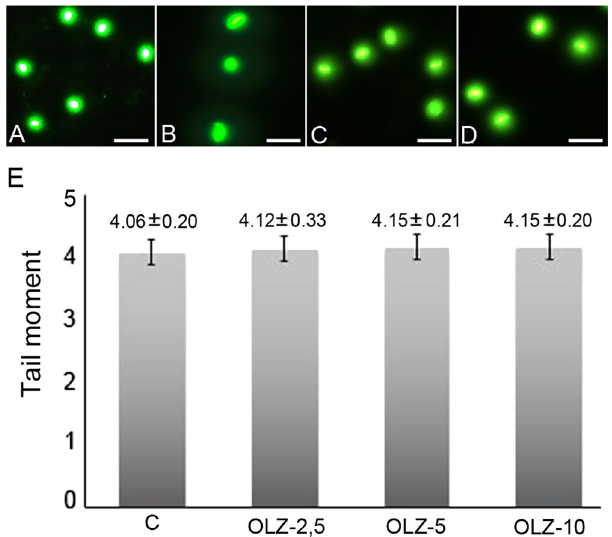
Figure 2. ( A–D ) Effect of olanzapine on the sperm DNA damage. ( A ) Sperm comet assay photo of control group ( B ) Sperm comet assay photo of OLZ-2.5 ( C ) Sperm comet assay photo of OLZ-5 ( D ) Sperm comet assay photo of OLZ-10. Stained with SYBR Green. Scale Bar:20 µm. ( E ) Sperm comet assay graphical illustration. No significant difference between groups in tail moment graph. Definition of abbreviations: OLZ-2.5 2.5 mg kg −1 olanzapine-administered rats for 28 days group, OLZ-5 5 mg kg −1 olanzapine-administered rats for 28 days group, OLZ-10 10 mg kg −1 olanzapine-administered rats for 28 days group. Results were given as mean ± standard